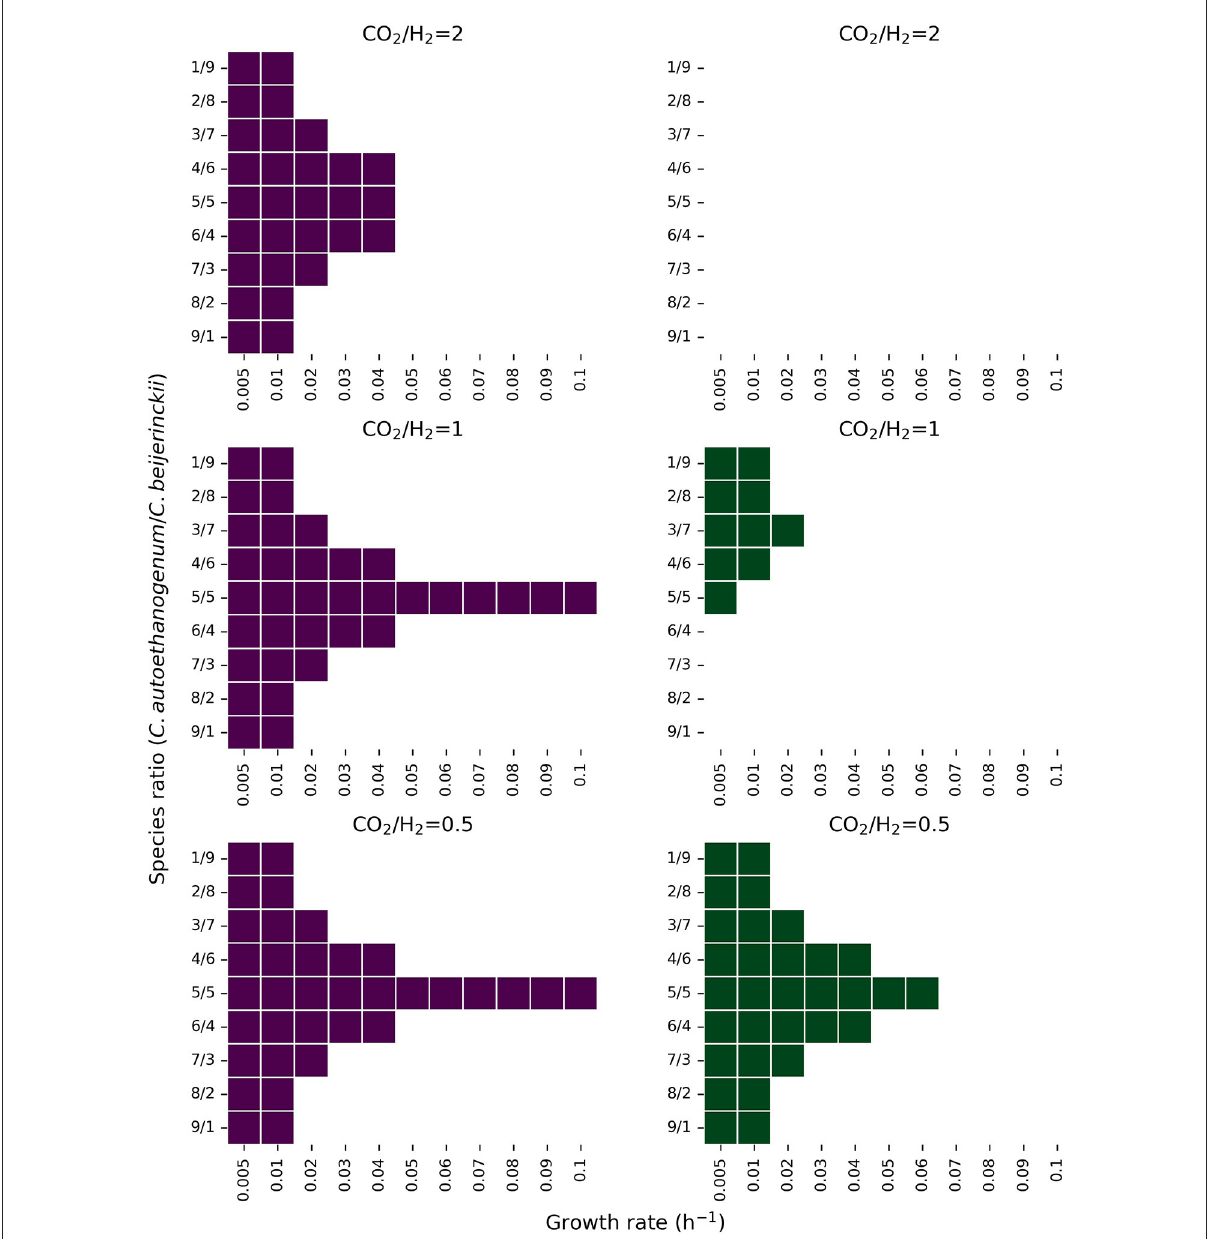
FIGURE6 Feasible solution space of the co-culture of C. autoethanogenum and C. beijerinckii for several species ratio and growth rate combinations under different CO 2 , H 2 , and lactate feed rates. The y-axis shows the biomass species ratio of C. autoethanogenum / C. beijerinckii and the x-axis shows the growth rate in h -1 . Colored areas indicate feasible solutions predicted by the model. Figures in purple and green show results when the lactate feed rate is set to a maximum of 5 mmol l -1 h -1 , and 2.5 mmol l -1 h -1 , respectively. Predictions shown on the first row were obtained with a CO 2 and H 2 feed rate of 5, and 2.5 mmol l -1 h -1 , respectively. Predictions shown on the second row were obtained with a CO 2 and H 2 feed rate of 5 mmol l -1 h -1 , and on the third row, with a CO 2 and H 2 feed rate of 2.5, and 5 mmol l -1 h -1 , respectively.